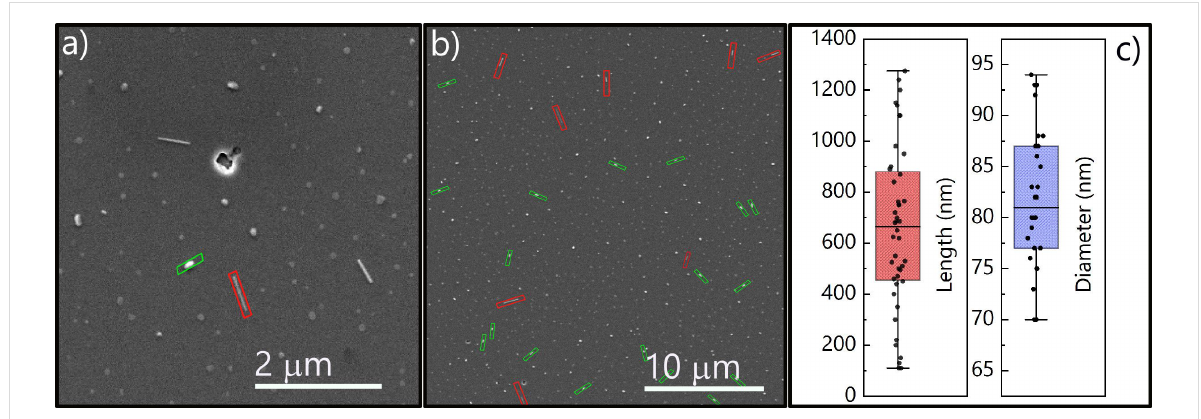
Figure 3: SEM images of the surface after deposition of 4.5 ML Mn on Ge(111) wafer and annealing at 650 °C for 15 min at (a) higher and (b) lower magnification. The two populations of 3D islands can be clearly distinguished with several small round islands and some long and short NWs. c) Length and diameter distribution of the NWs. The whiskers define minimum and maximum value of each dimension, while the boxes show the 25th and 75th percentile of the distribution with the middle line representing the average value of ≈ 700 nm for the length and ≈ 80 nm for the diameter.